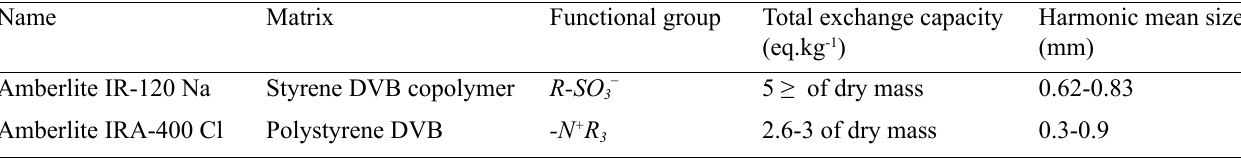
Table 1. Properties of the cationic and anionic